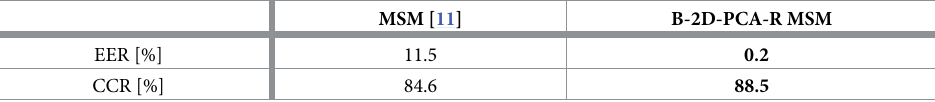
Table 6. Equal error rate (EER) and correct classification ratio (CCR) of MSM-based method [11] and the B- 2D-PCA-R MSM, for dataset 1.